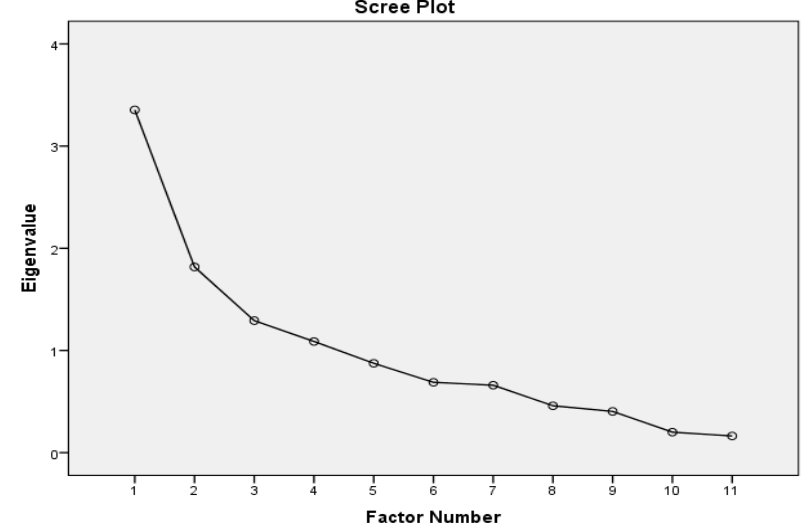
Figure 1. Scree plot confirming the factor number with eigenvalue (>1). Table 4. Four ‐ factor model of principal component analysis for 11 items.